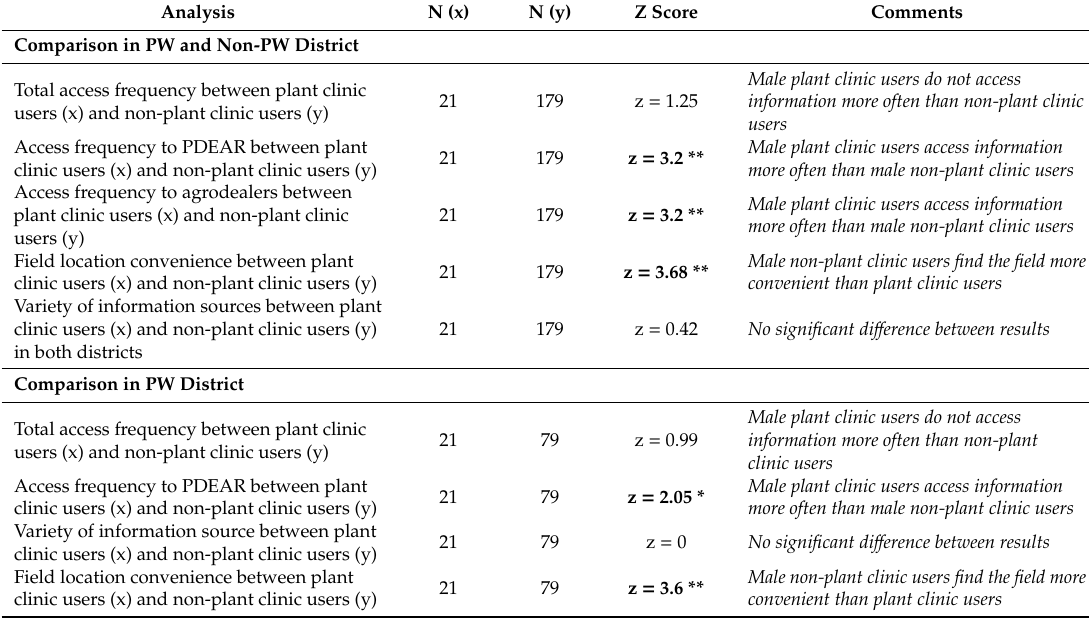
Table 2. Plant clinic users and non-plant clinic users’ perceptions of information access in Plantwice (PW) and non-PW